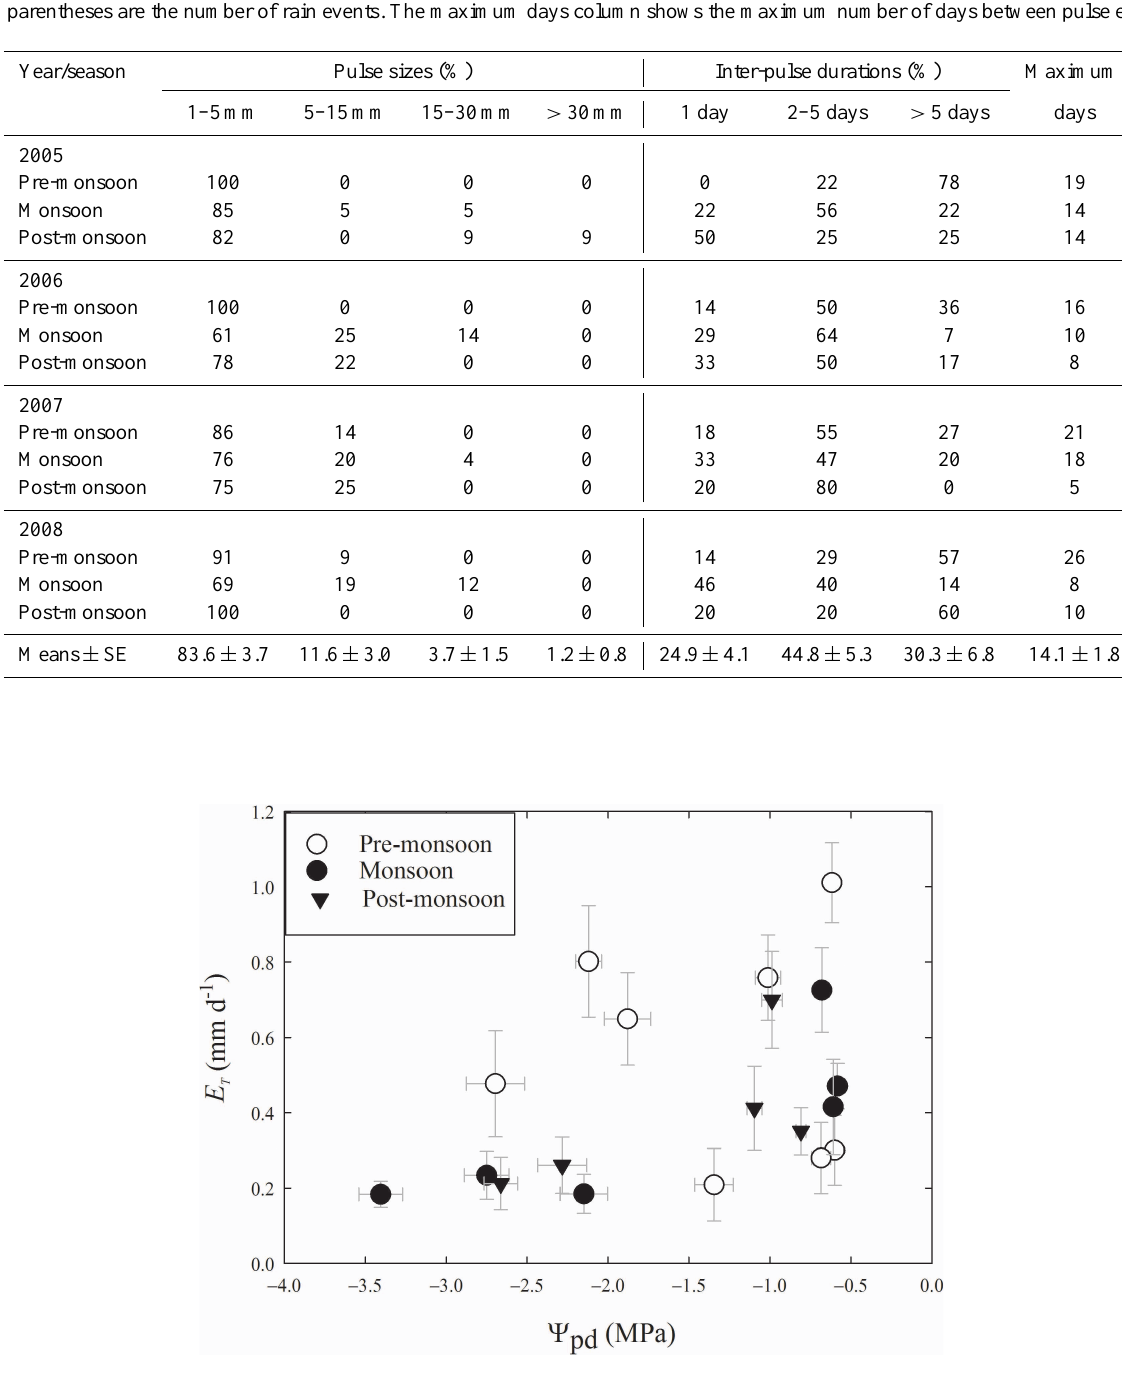
Fig. A1. The relationship between monthly juniper pre-dawn leaf water potential ( 9 pd ) and E T by season. The number of data points is limited because not all monthly 9 pd observations had corresponding E T